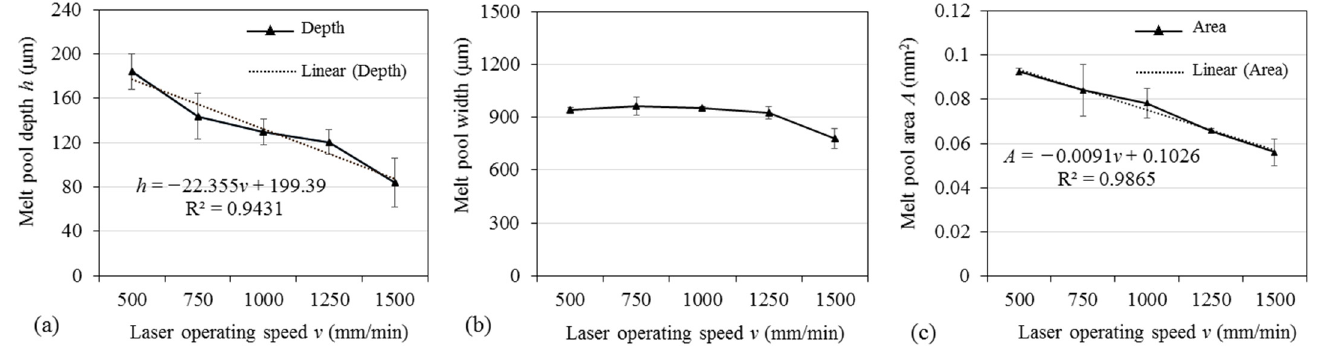
Figure 4. Depth ( a ), width ( b ) and area ( c ) of melt pool obtained by laser processing at 0.5 mm laser spot diameter with boron in relation to laser operating speed.